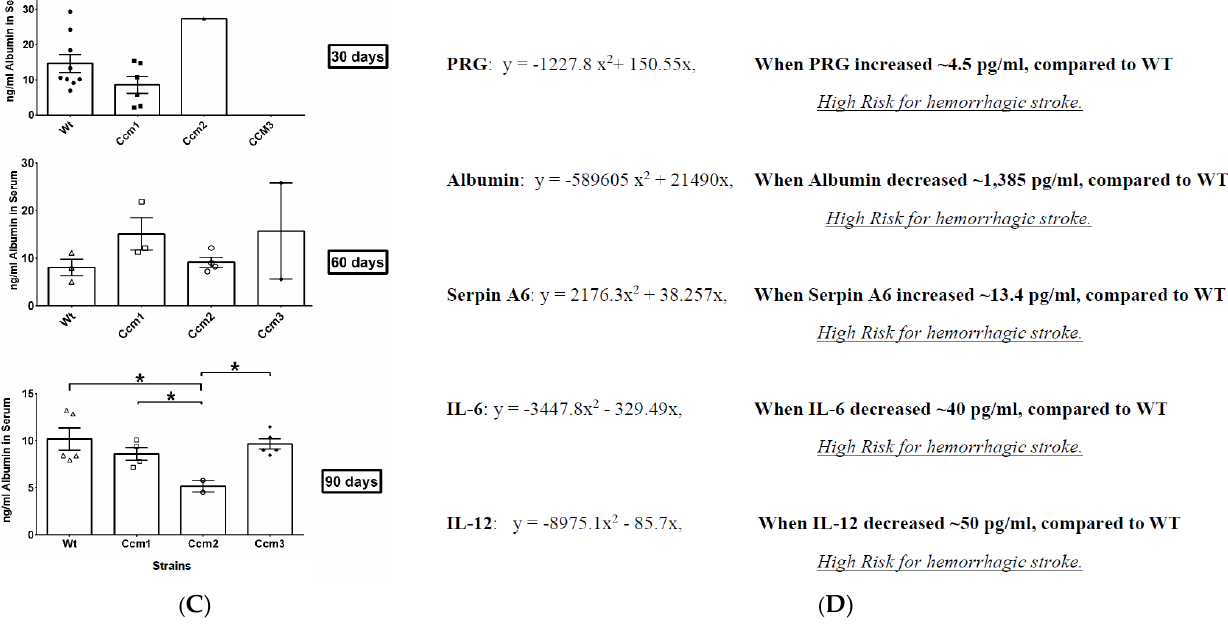
Figure 6. Perturbation of homeostasis of PRG is associated with BBB disruption. ( A ) No obvious differences in PRG levels in mice serum were observed in the 30 ‐ day treatment groups (upper panel). Interestingly, free ‐ circulating PRG levels in the mice serum have an overall two ‐ fold increase among all treated genotypes in the 60 ‐ day treatment groups (although not statistically significant, middle panel). In the 90 ‐ day treatment groups, free ‐ circulating PRG levels regressed to normal